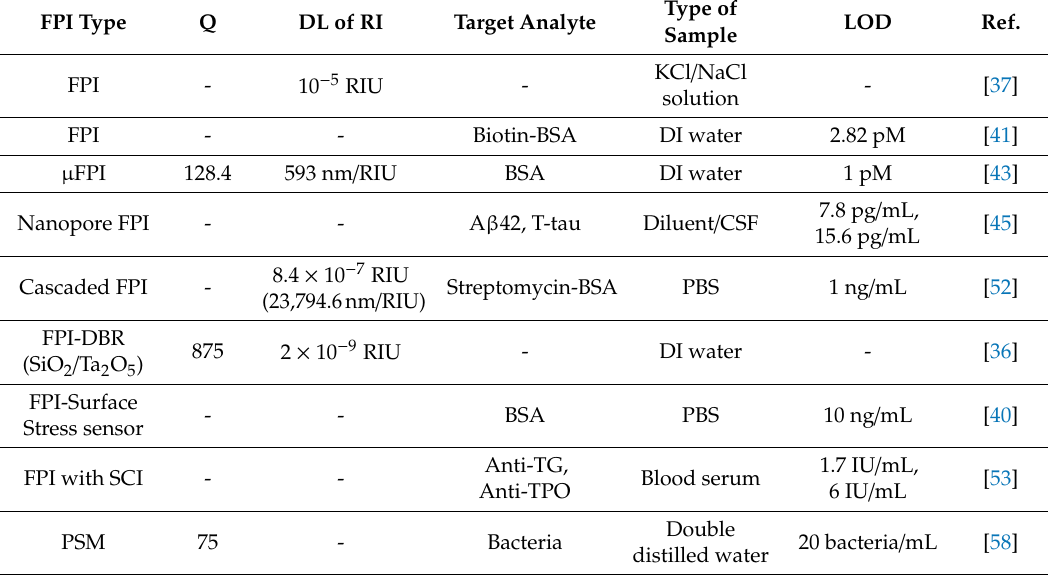
Table 1. Summary of FPI-based biosensors.